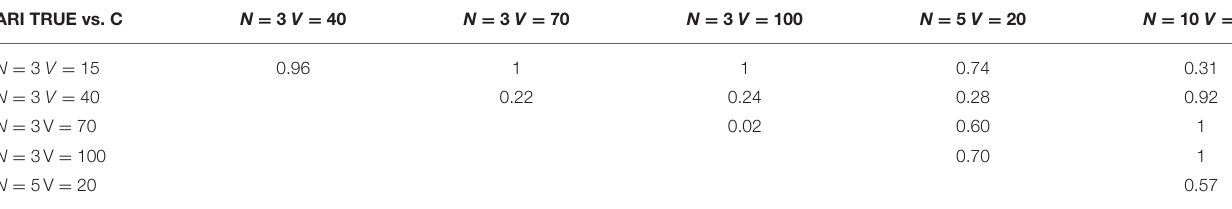
TABLE 1 | Concordance between classification results and simulated hypothesis. ARI TRUE vs.